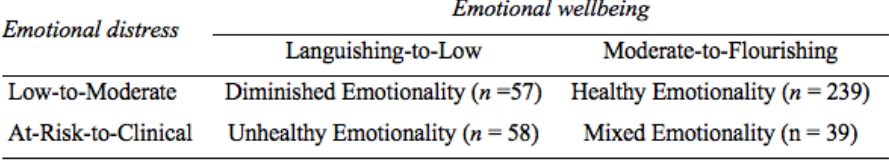
Bidimensional emotional health status of